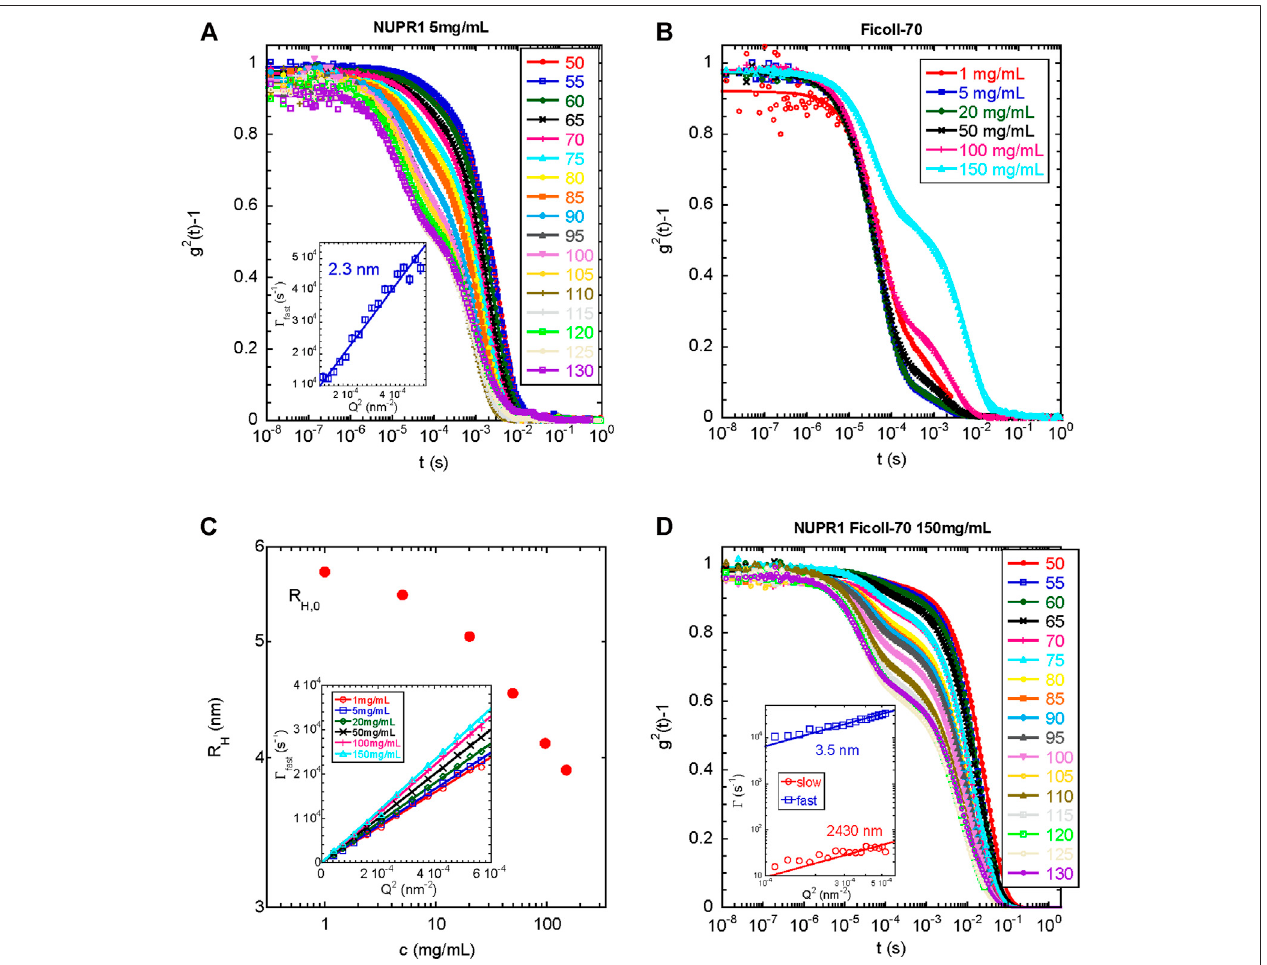
FIGURE 5 | DLS under different conditions for wild-type NUPR1: (A) Intensity autocorrelation functions at different angles indicated for NUPR1 solutions at 5 mg/ml. Solid lines correspond to fi ts using Eq. 1 (B) Intensity autocorrelation functions at 90 ° for Ficoll-70 solutions in water from 1 to 150 mg/ml (C) Hydrodynamic radiusasafunctionoftheconcentrationofFicoll-70. Inset:Fast relaxation ratesobtainedfrom fi ttingthecorrelation functionswith Eq.1 .Thesolid lines represent the fi ts to 1/ τ (cid:2) D Q 2 (D) Intensity autocorrelation functions at different angles of a mixed solution of NUPR1 4.3 mg/ml and Ficoll-70 150 mg/ml. Solid lines correspond to fi ts using Eq. 2 . Inset: Q-dependence of the slow and fast relaxation